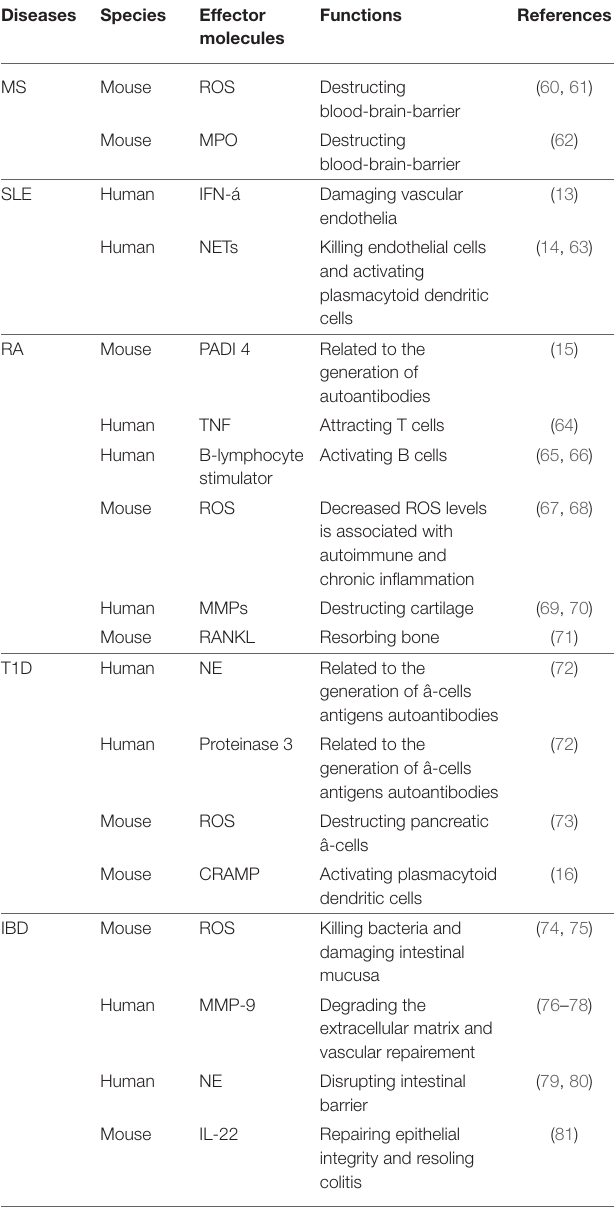
TABLE 1 | Neutrophils in autoimmune